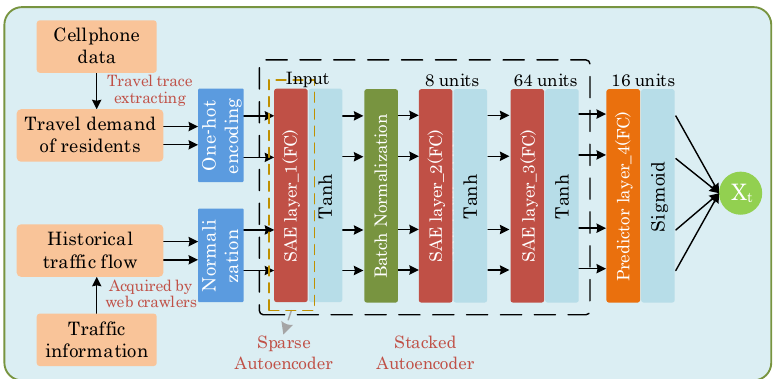
Figure 8. The structure of the SAE